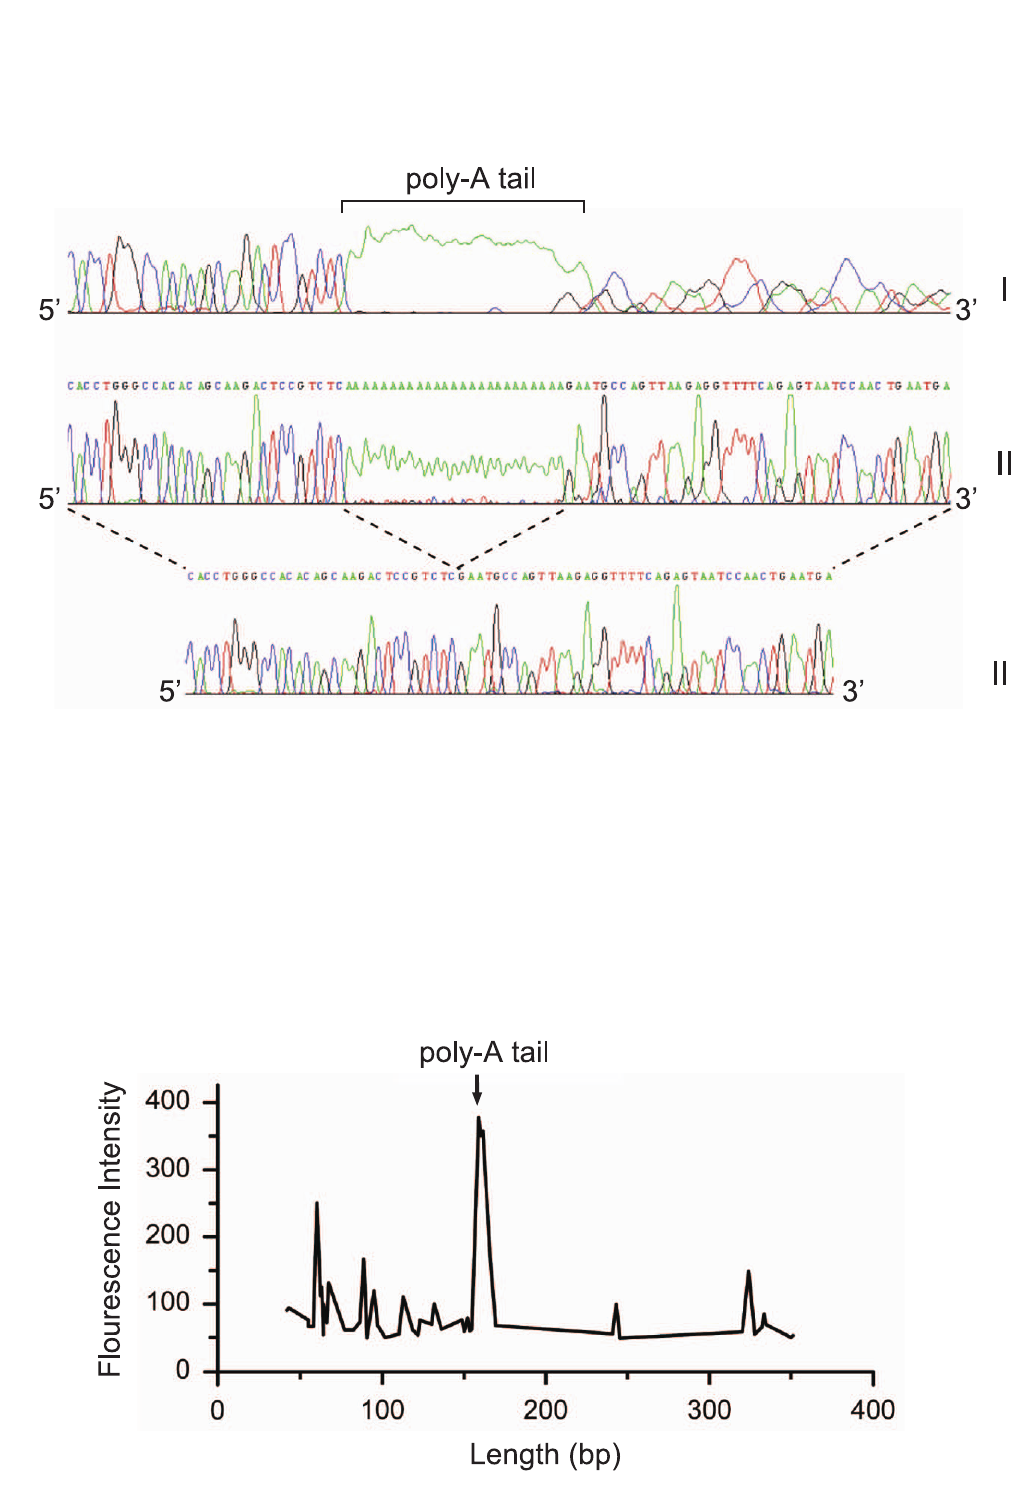
Figure 6. DNA conformational irregularities around AluYi6-AH151. (A) Panel I shows sequencing read of linear PCR product generated from S1–S29 genomic region serving as template. The sequence 3 9 to the Alu poly-A tail could not be read properly. In Panel II, when the same sequence in Panel I was cloned and subsequently sequenced from the circular pMD18-T vector, its circular conformation allowed proper reading of the sequence 3 9 to the Alu poly-A tail. In Panel III, the Alu poly-A tail had been deleted, and the region 3 9 to Alu could be read even with linear PCR product serving as sequencing template. (B) DNase I sensitivity assay on fluorescent 6FAM-labelled PCR products containing Alu Yi6-AH151 (Methods), showing site of enhanced nuclease-sensitivity at the start of the Alu poly-A tail.